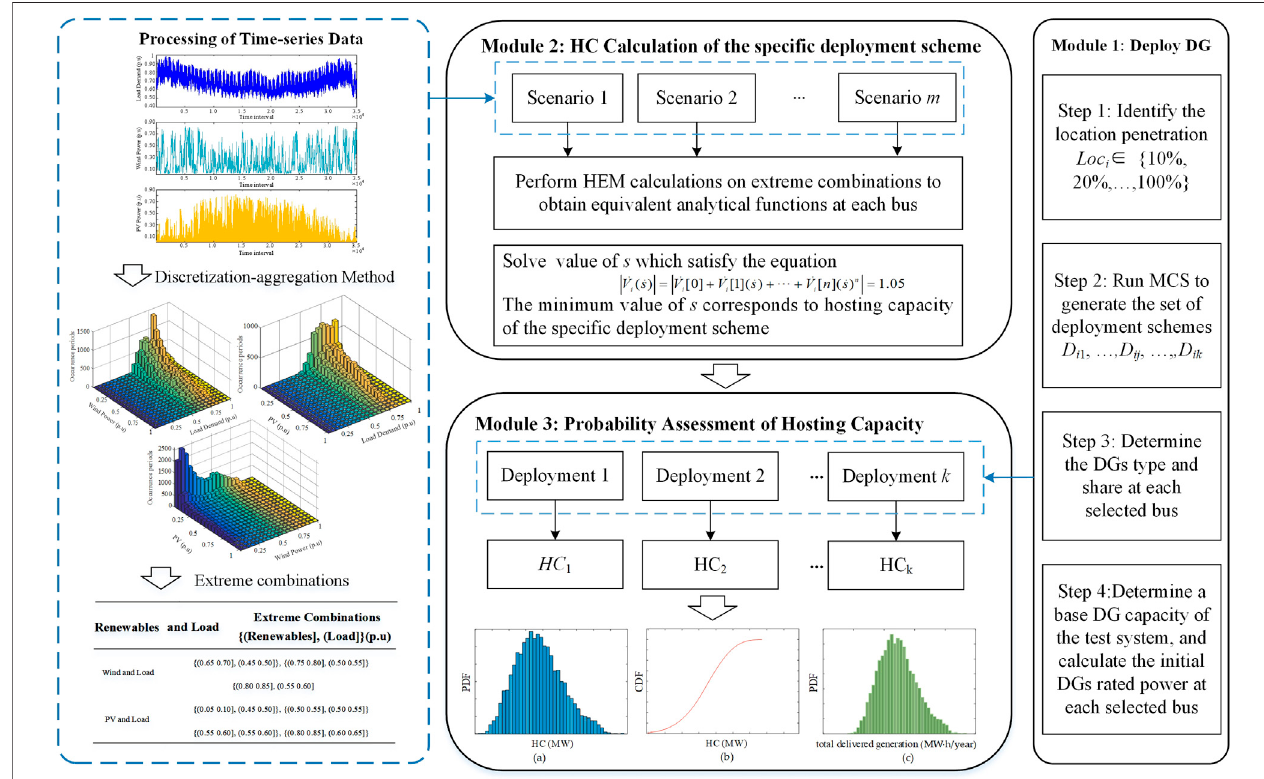
FIGURE 4 | Stochastic framework for the hosting capacity assessment.